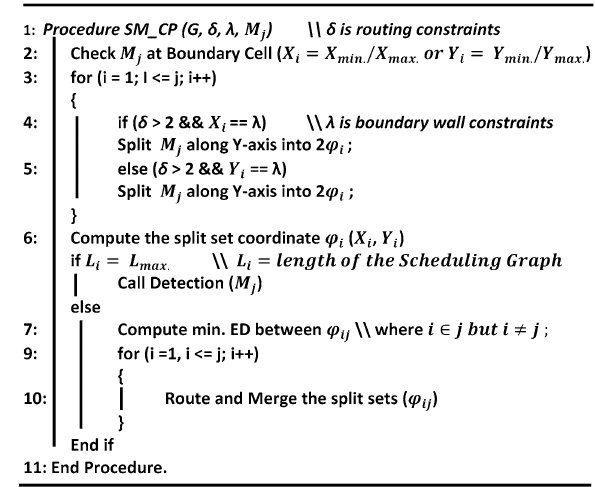
Table 5 Rate of mixing completion with respect to time in sec., for the 1 st label of PCR assay on MEDA